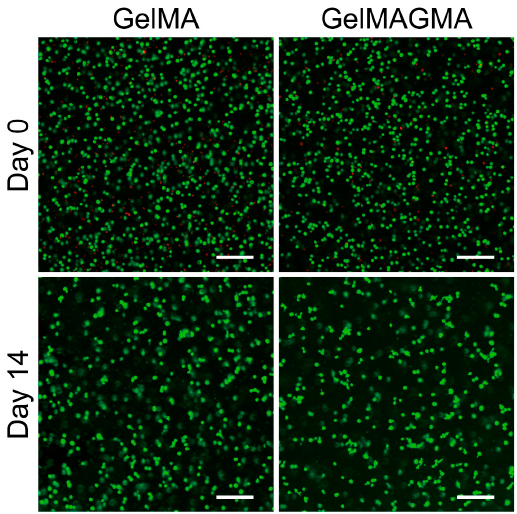
Figure 4. Live and dead staining of chondrocytes in GelMA and GelMAGMA hydrogels after UV crosslinking (Day 0) and after 14 days in vitro culturing (Day 14). Scale bar = 200 µm. (Green: live cells; Red: dead cells).